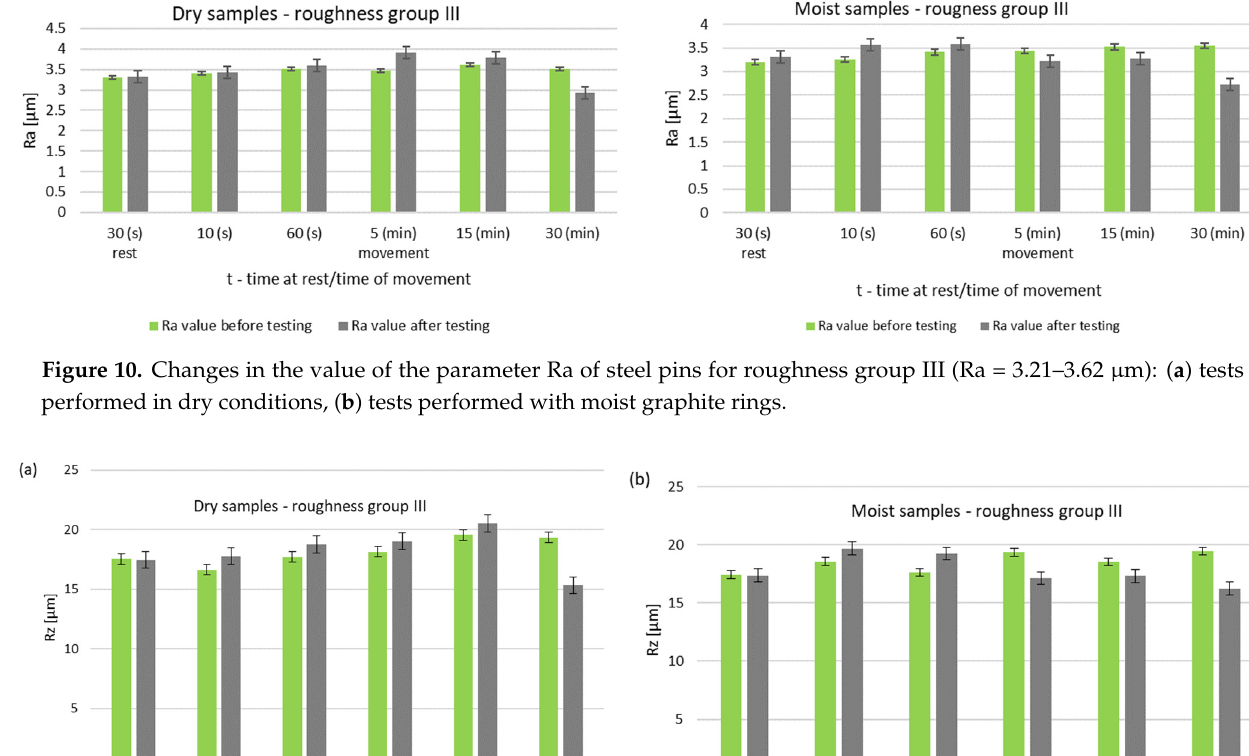
Figure 9. Comparison of Rz values of dry and wet ring samples for group II roughness.